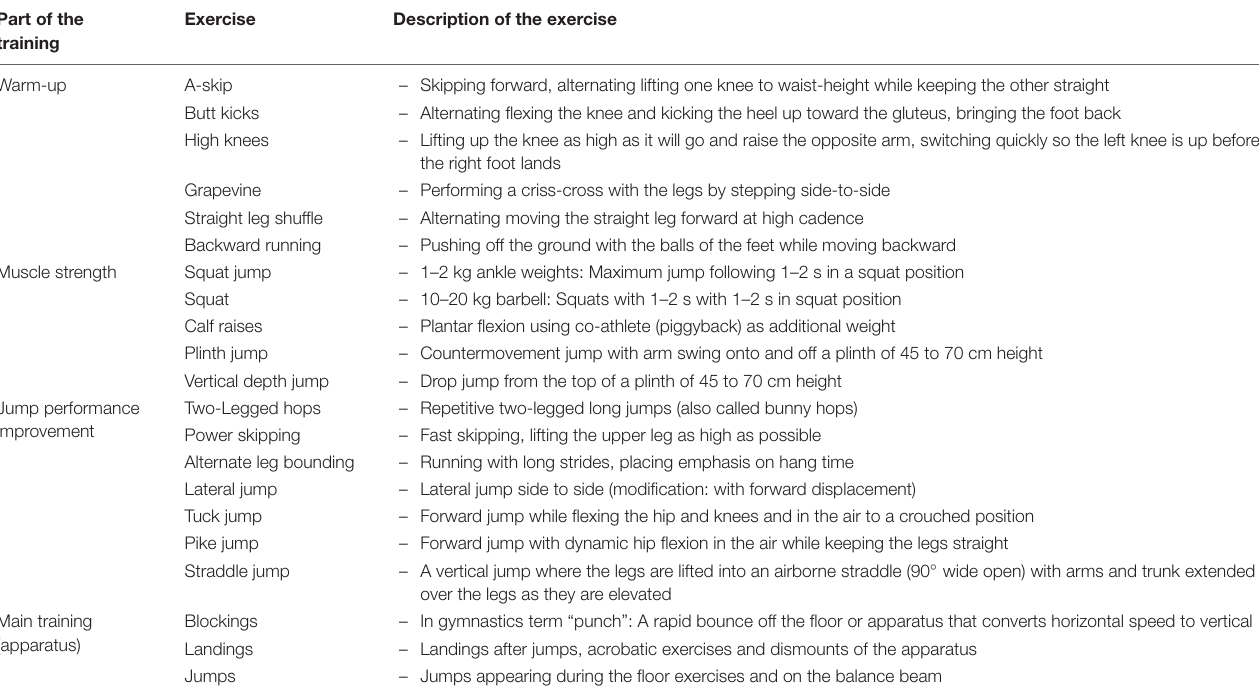
TABLE 1 | Detailed description of each exercise for the lower extremities documented for the quantification of the training intensity and volume. Part of the